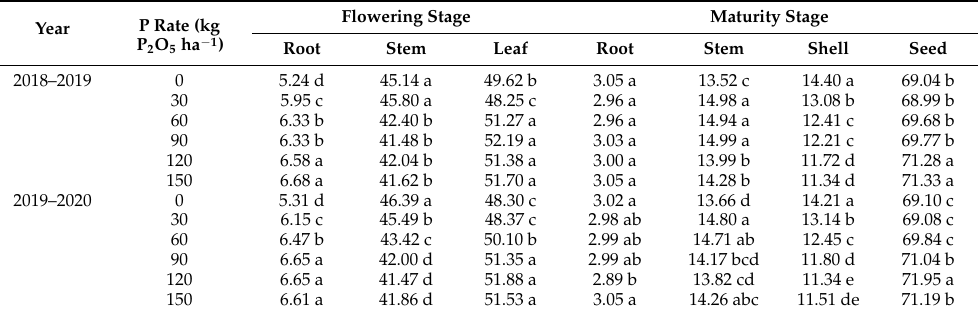
Different letters indicate significant difference at p = 0.05 between P rate treatments during the same growing season.